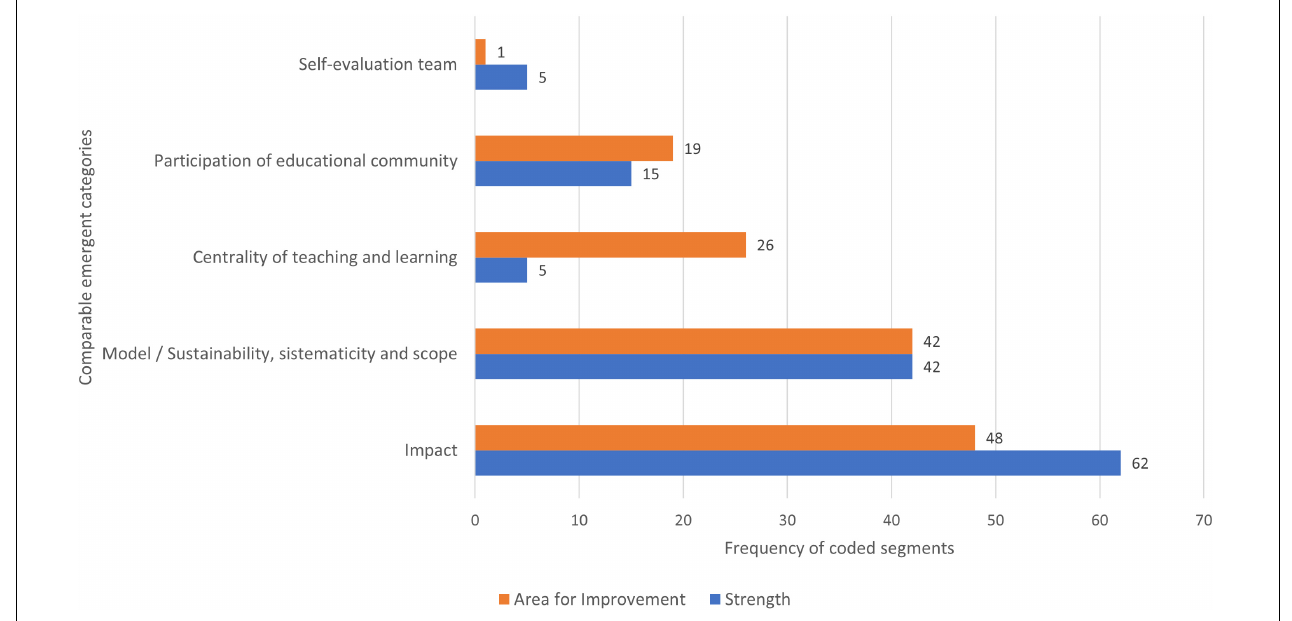
FIGURE 4 | Self-evaluation: a comparison between strengths and areas for improvement.